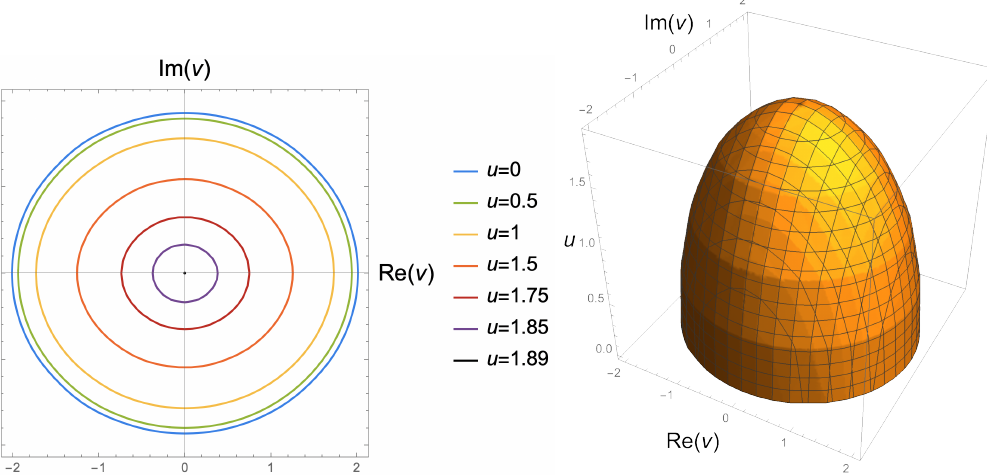
(b) K = 0 contours in the complex v -plane, for real u when u & 1 . 89 . The K = 0 surface plotted in the right panel is the 3D visualization of the contours plotted in the left panel. Figure 4. K = 0 contours for gauge group SU(3) , plotted via the method of appendix